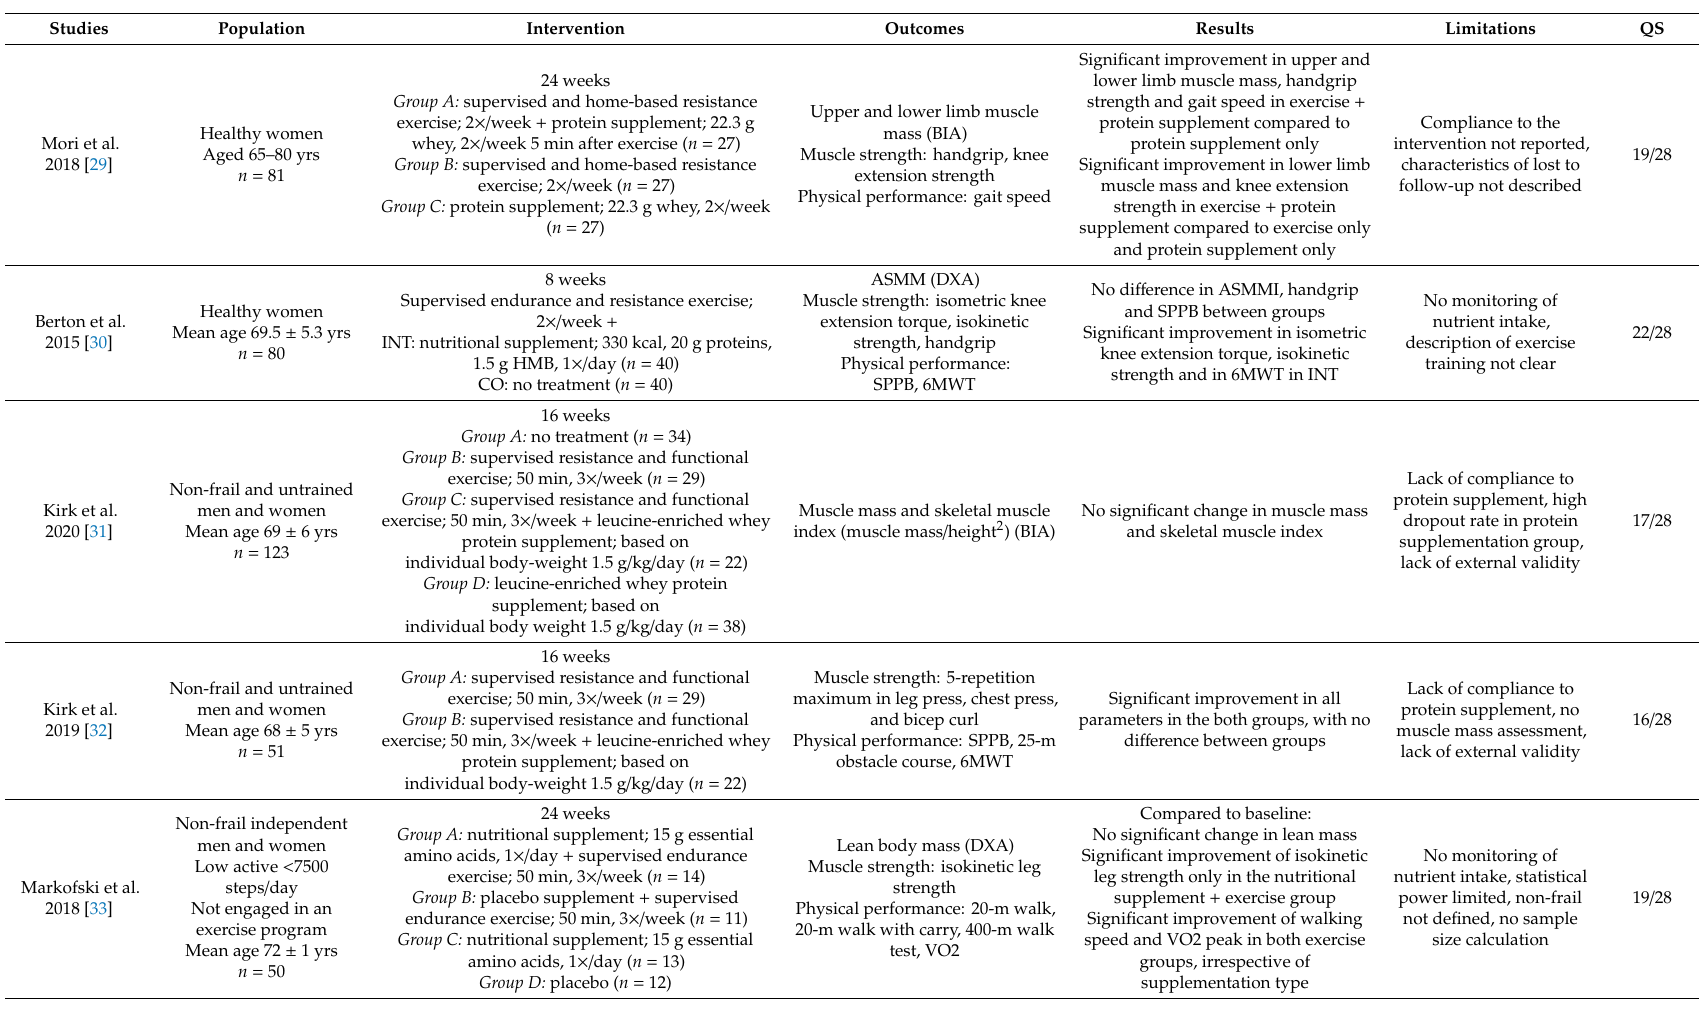
Table 2. Combined nutritional and physical activity / exercise interventions in community-dwelling older adults.